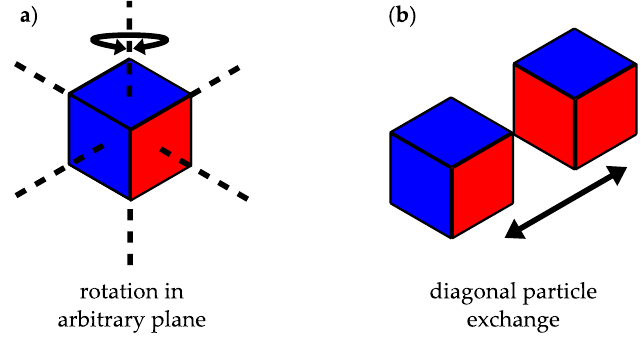
Figure 2. Illustration of MC moves. ( a ) particle (cube) rotation; ( b ) neighbouring particle